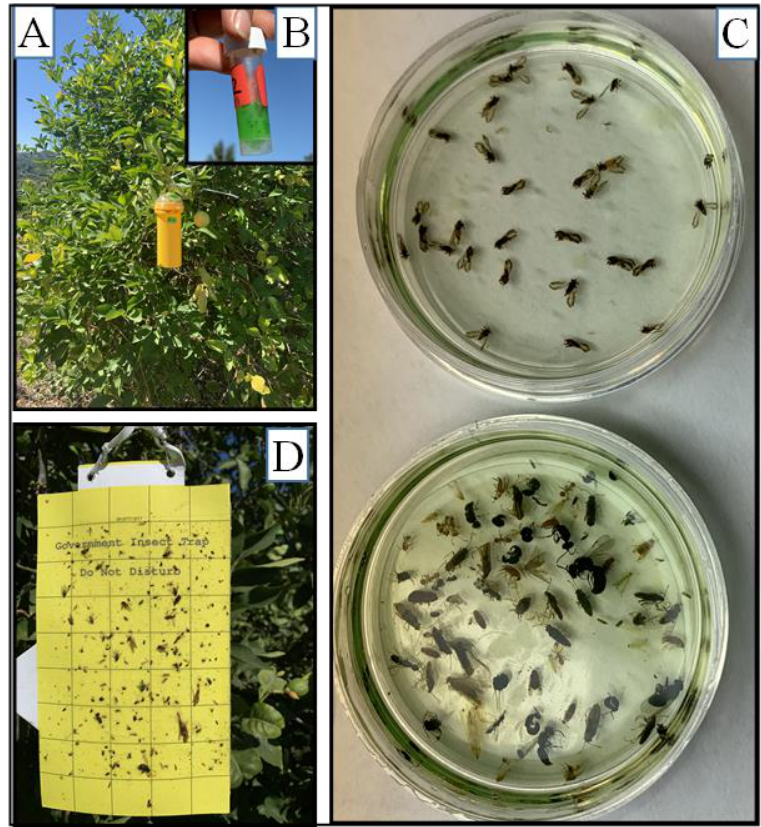
Figure 8. Cylinder trap 1 deployed in a citrus grove in Temecula, CA. Panel ( A ): Trap on a citrus tree. Panel ( B ) (inset) shows the capture tube from the trap with insects. Panel ( C ) shows 28 ACPs (top Petri dish) and by-catch (bottom Petri dish) captured in 1 trap during a 6-week period. Psyllids were separated in the lab. ACPs were clearly recognizable six weeks after capture since they were not degraded. Panel ( D ) shows a yellow sticky trap on an adjacent tree; a magnifying lens was required to identify and count the 20 degraded psyllids on the sticky trap.